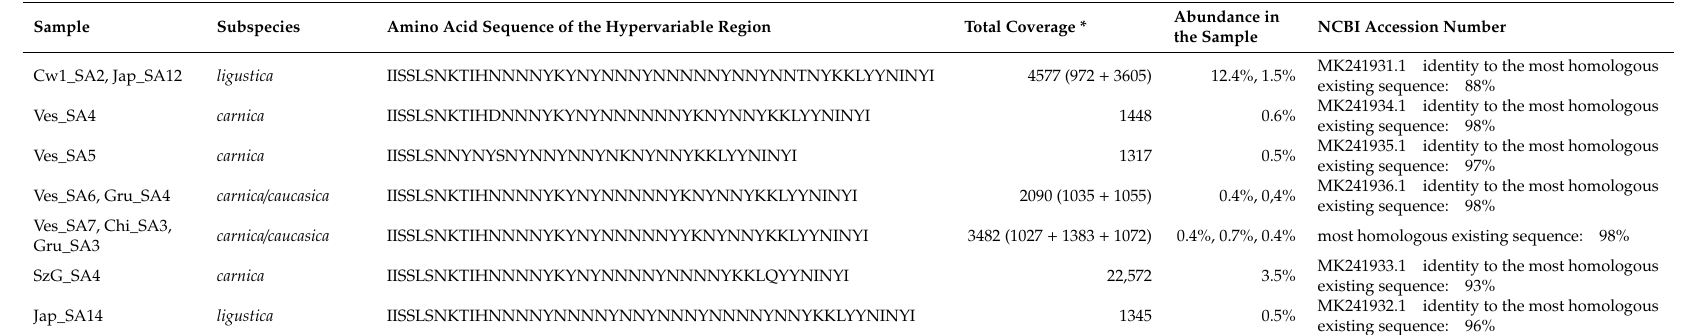
Table 3. New alleles reported in the present